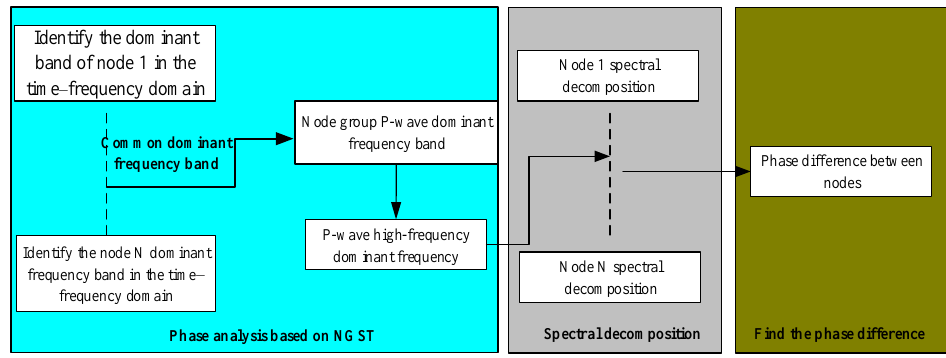
Figure 3. Flowchart of the phase-difference extraction.